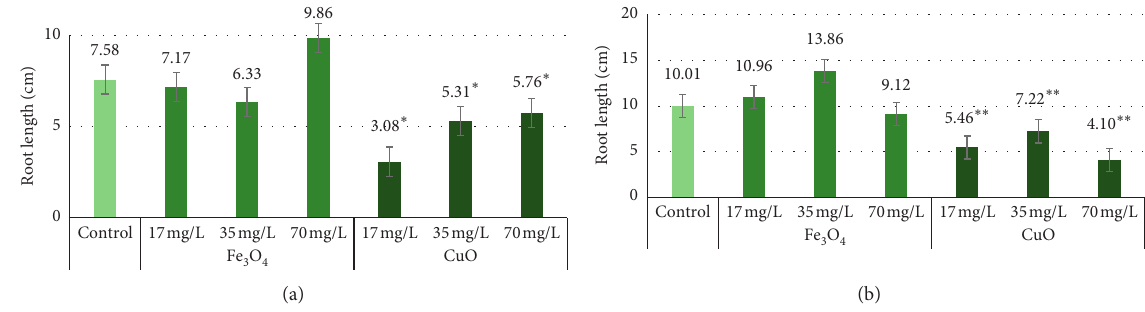
Figure 2: The “Marthe” and “KWS Olof” varieties root length with 17mg/L, 35 mg/L, and 70mg/L concentrations of Fe Values are the mean of three replicates with SD. ∗ Indicates a significant difference from control ( p < 0.01). (a) “Marthe” variety root length with different concentrations of Fe 3 O 4 and CuO NPs. (b) “KWS Olof” variety root length with different concentrations of Fe 3 O 4 and CuO